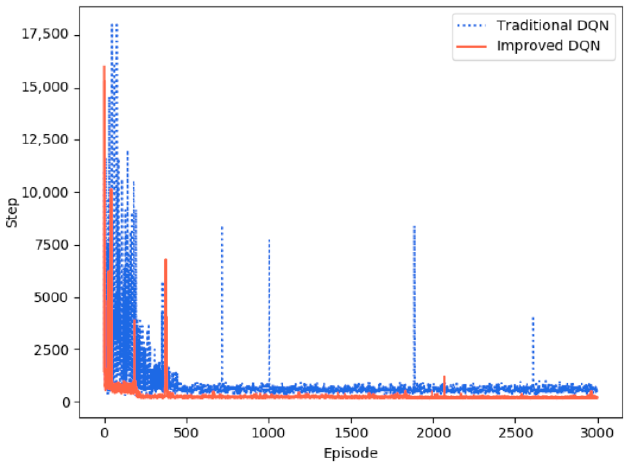
Figure 14. The convergence trend comparison results of step iteration.